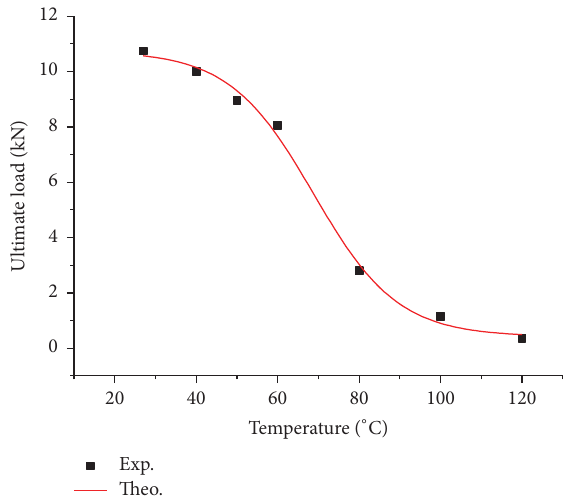
Figure 6: Ultimate load of specimens at elevated temperatures. Figure 7: Interfacial fracture energy of specimens at elevated